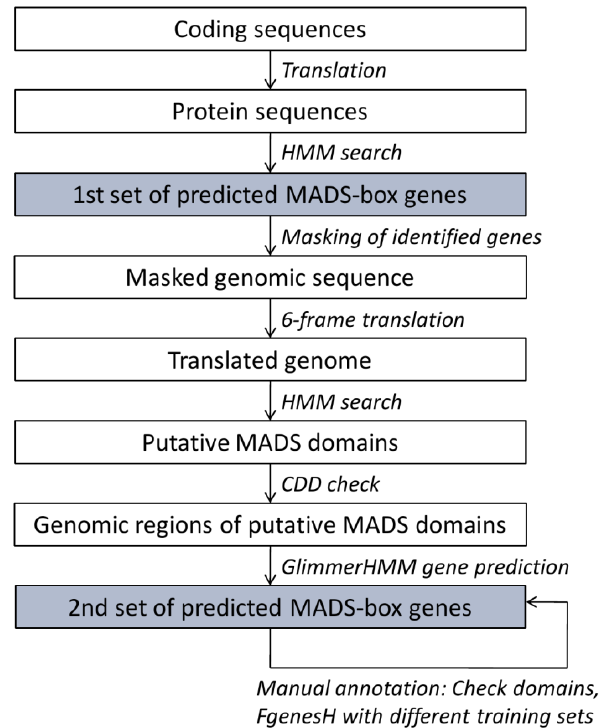
Figure 2. Pipeline for annotation of MADS-box genes in plants. The two sets of predicted MADS-box genes are combined to obtain what is presumably the full complement of MADS-box genes in a species.